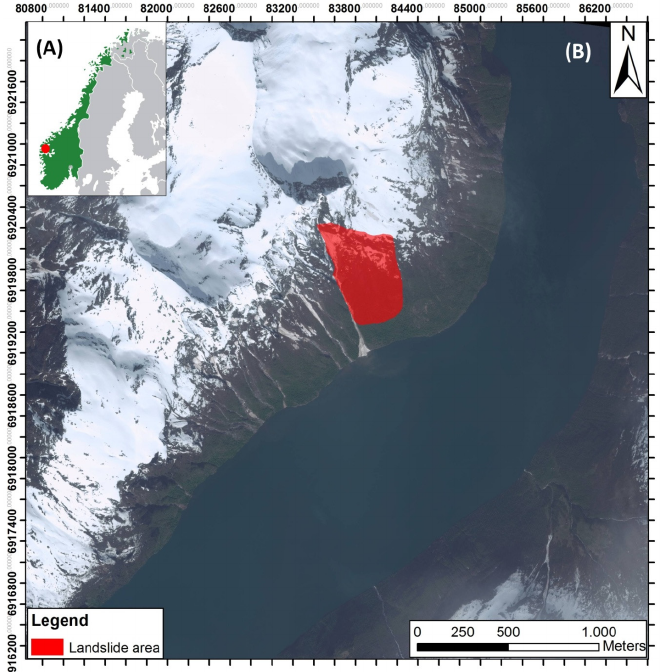
Figure 3. Åknes rockslide location on the Norwegian coast ( A ) and zoom on the area affected by the rockslide, whose location is emphasized by a red polygon ( B